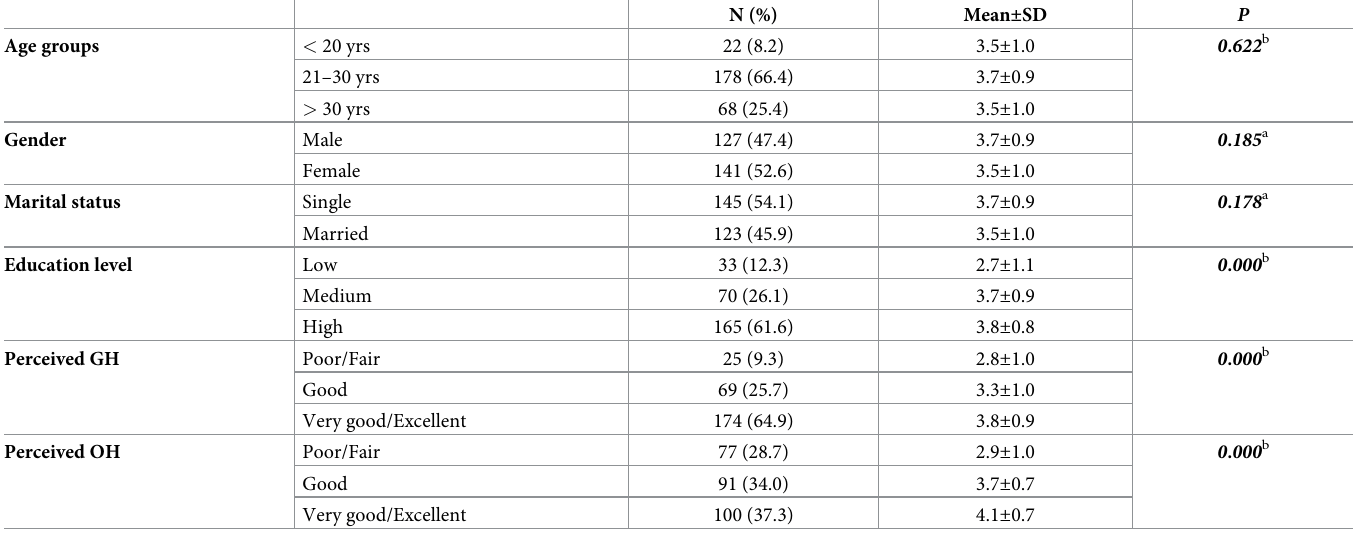
Table 1. Number, percentage, and mean ± SD of responses to OES-Ar by study